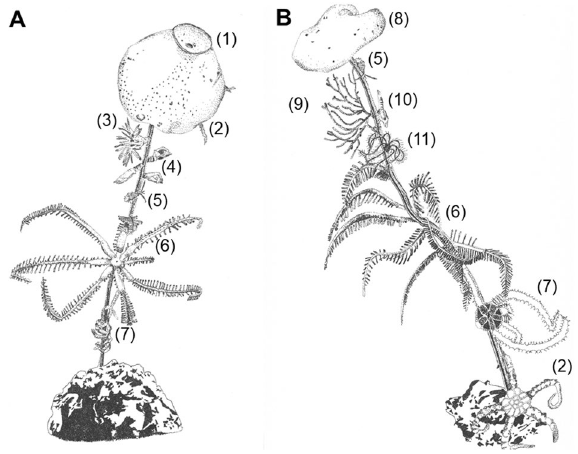
Figure 3. Drawings of highest impact taxa. ( A ) The highest impact taxon in the Clarion-Clipperton Fracture Zone (CCZ), the hexactinellid sponge Hyalonema sp., and ( B ) the highest impact taxon in the Peru Basin, the hexactinellid sponge Caulophacus sp., are shown with their corresponding associated fauna (on Order level) with which they have non-trophic interactions. The taxa presented in the drawings are the following: (1) Hyalonema sp., (2) Ophiurida, (3) Actiniaria, (4) Cirripedia, (5) Amphipoda, (6) Brisingida, (7) Ophiacanthida, (8) Caulophacus sp., (9) Alcyonacea, (10) Mysida, and (11) Comatulida. Illustrations by Tanja